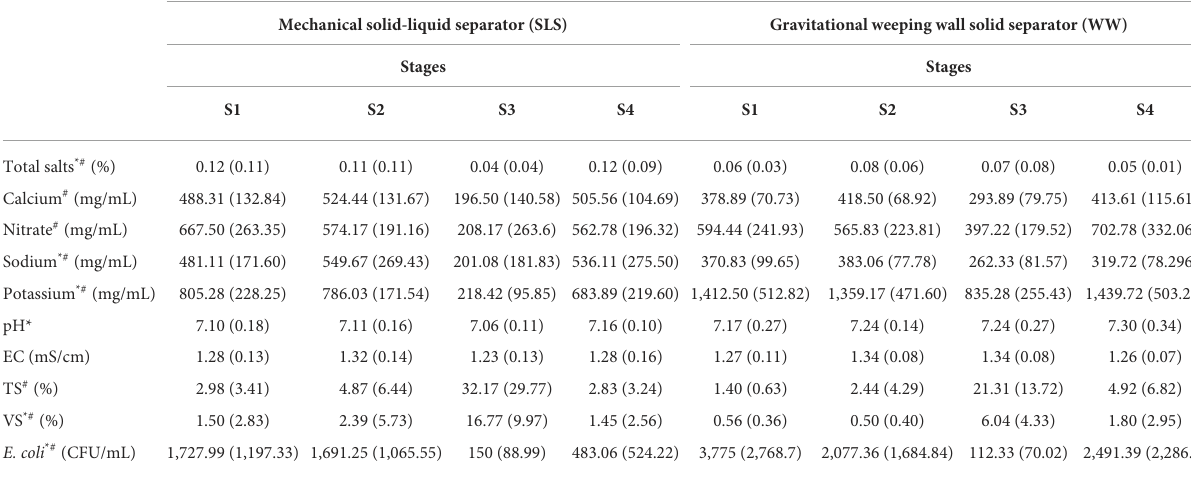
TABLE 1 Descriptive effluent characteristics in dairy effluent management